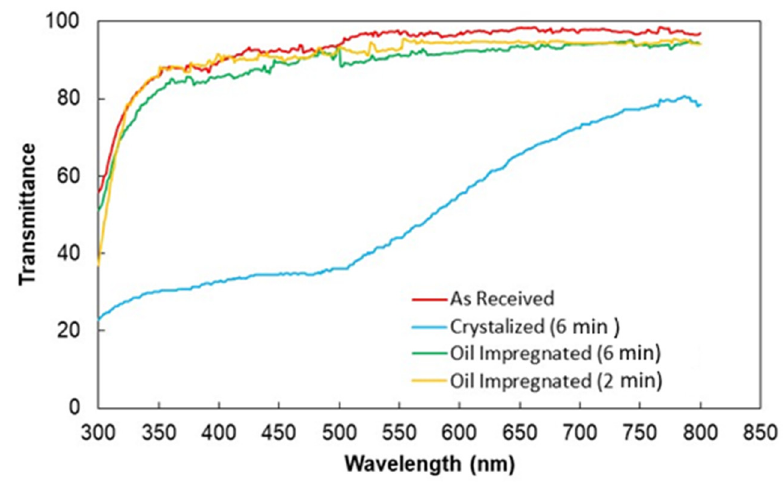
Figure 8. UV visible transmittance of treated surfaces prior and after oil impregnation. Optical transmittance of as received polycarbonate is also provided for comparison.